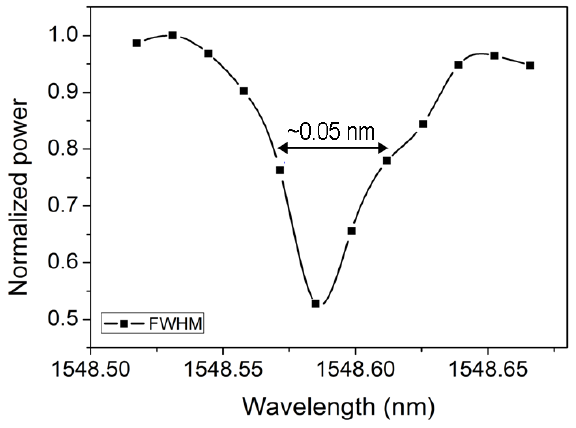
Figure 9. The FWHM of the MRR resonance from thermal DFB wavelength tuning.